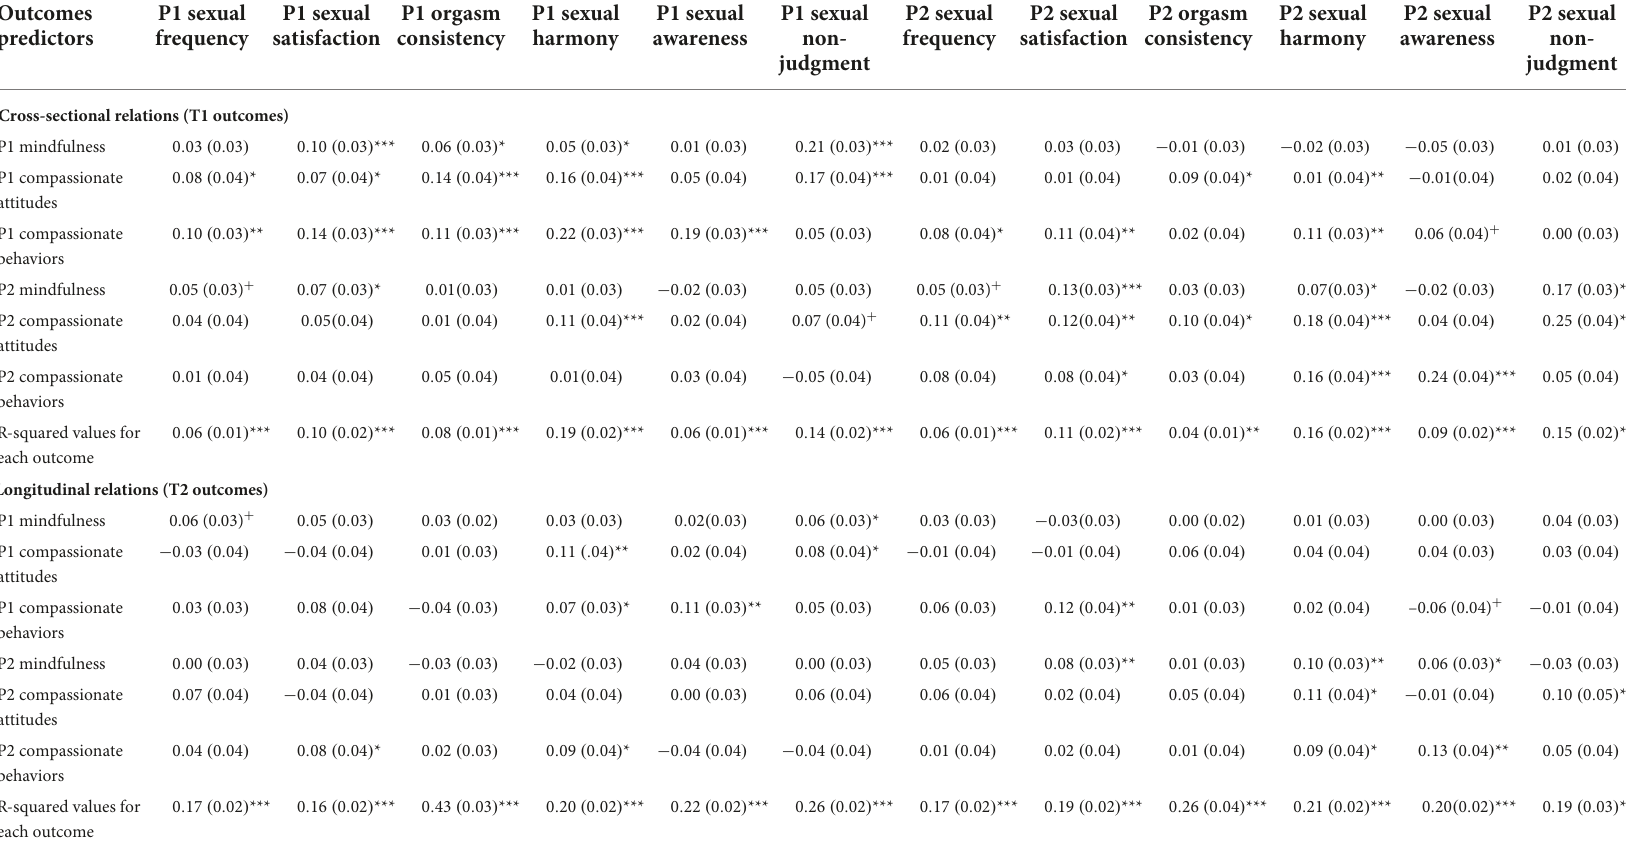
TABLE 2 Relations between partner 1 (P1) and partner 2 (P2) relationally compassionate constructs at T1 and sexual well-being for self and partner cross-sectionally (T1) and longitudinally (T2) presented as β (standard